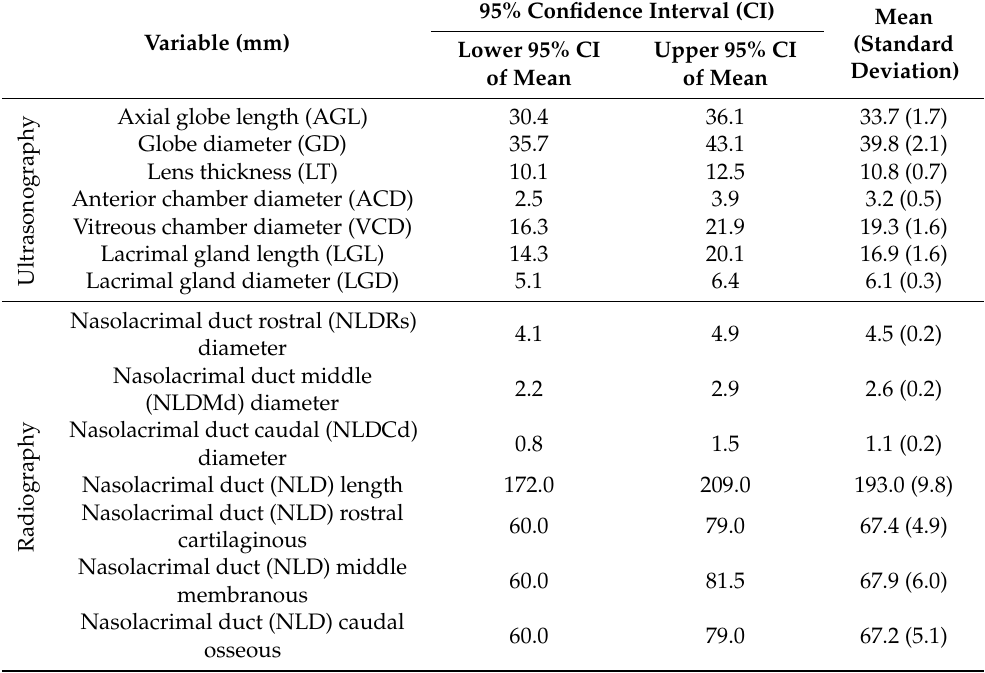
Table 1. Descriptive statistical analysis of the globe, lacrimal gland, and NLD biometric measurements on ultrasonographic and radiographic imaging of 21 clinically normal live